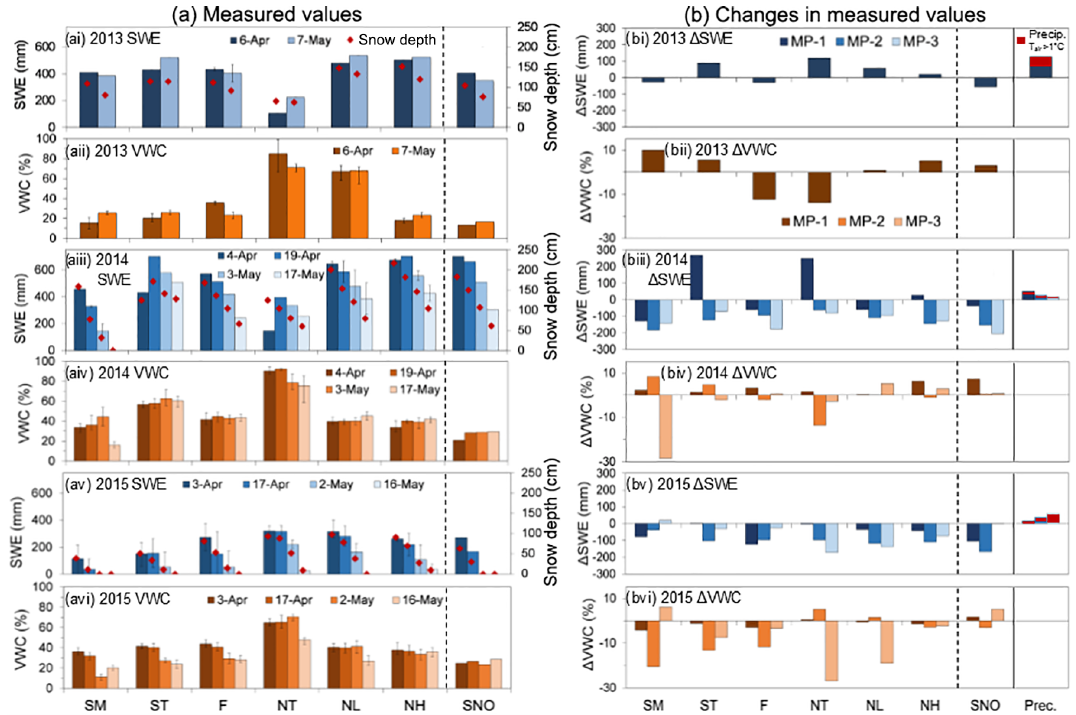
Figure 4. Observations of (a) measured values for snow water equivalent (SWE) and near-surface soil volumetric water content (VWC) and (b) changes in measured values between survey dates for regions of interest: middle of the south aspect hillslope (SM), toe of the south aspect slope (ST), flat aspect (FA), toe of the north aspect slope (NT), low on the north aspect slope (NL), and high on the north aspect slope (NH). Also included are observed values at the SNOTEL site (SNO) that include SWE and precipitation (Precip.) with precipitation that fell when air temperature ( T air ) was greater than 1 ◦ C shown in red. Figure panels display (i) 2013 SWE, (ii) 2013 VWC, (iii) 2014 SWE, (iv) 2014 VWC, (v) 2015 SWE, and (vi) 2015 VWC. Changes are shown for melt period 1 (MP-1) between the first two surveys, melt period 2 (MP-2) between the second and third surveys, and melt period 3 (MP-3) between the third and fourth surveys. Each melt period is 14–15 days with the exception of in 2013, which was 28 days. Error bars indicate total range of measurements at locations.